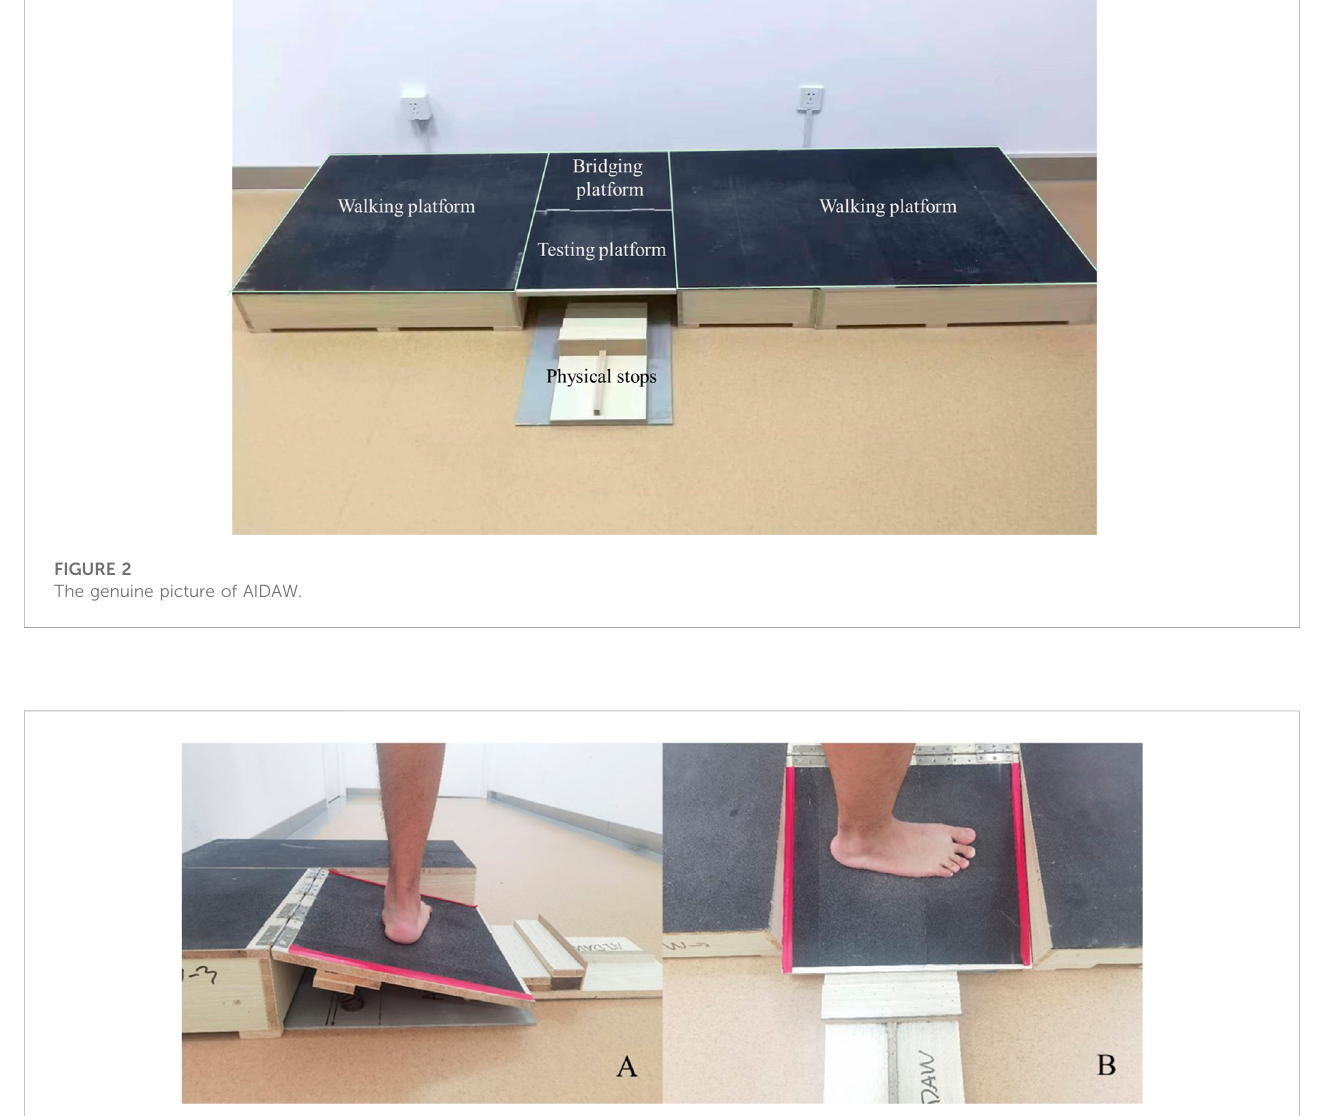
inversion position. For the formal test, the 4 possible ankle inversion positions appeared randomly, and each inversion position appeared 10 times, for 40 trials in total. Participants were instructed to report their perceived ankle inversion position on each trial, without feedback on the correctness of their judgement. The actual presented positions and participants ’ perceived positions were recorded on each trial for data analysis. Each participant would have 40 ankle inversion position stimuli and corresponding responses intotal. The total test time was about10 min. For the YBT, participants stood on the standing block with the tested leg, and used the other foot to push the slide block as far as possible in anterior, posteromedial, and posterolateral directions (Figure 6) (Wilson et al., 2018). Before data collection, participants were given 2 rounds of familiarization. In the formal test, participants completed the test for 3 rounds, with 1 min rest in between. The distances achieved in